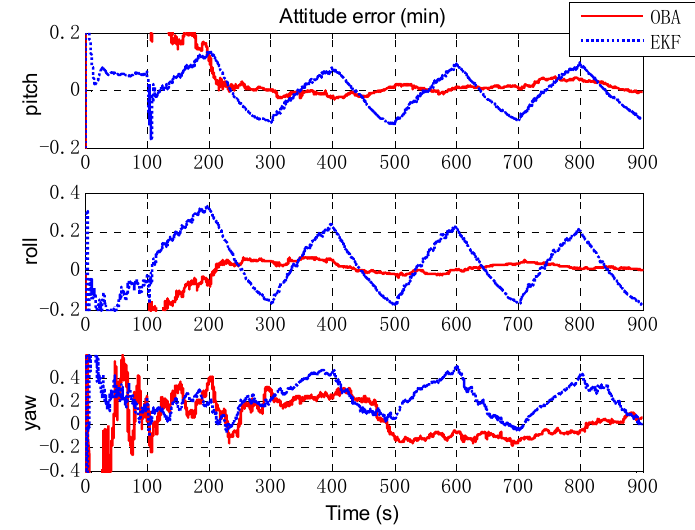
Figure 9. The estimation of attitude error. The red solid line denotes the estimation by OBA, and the blue dashed line denotes the estimation by EKF. The three figures are the attitude errors of pitch, roll and yaw respectively.